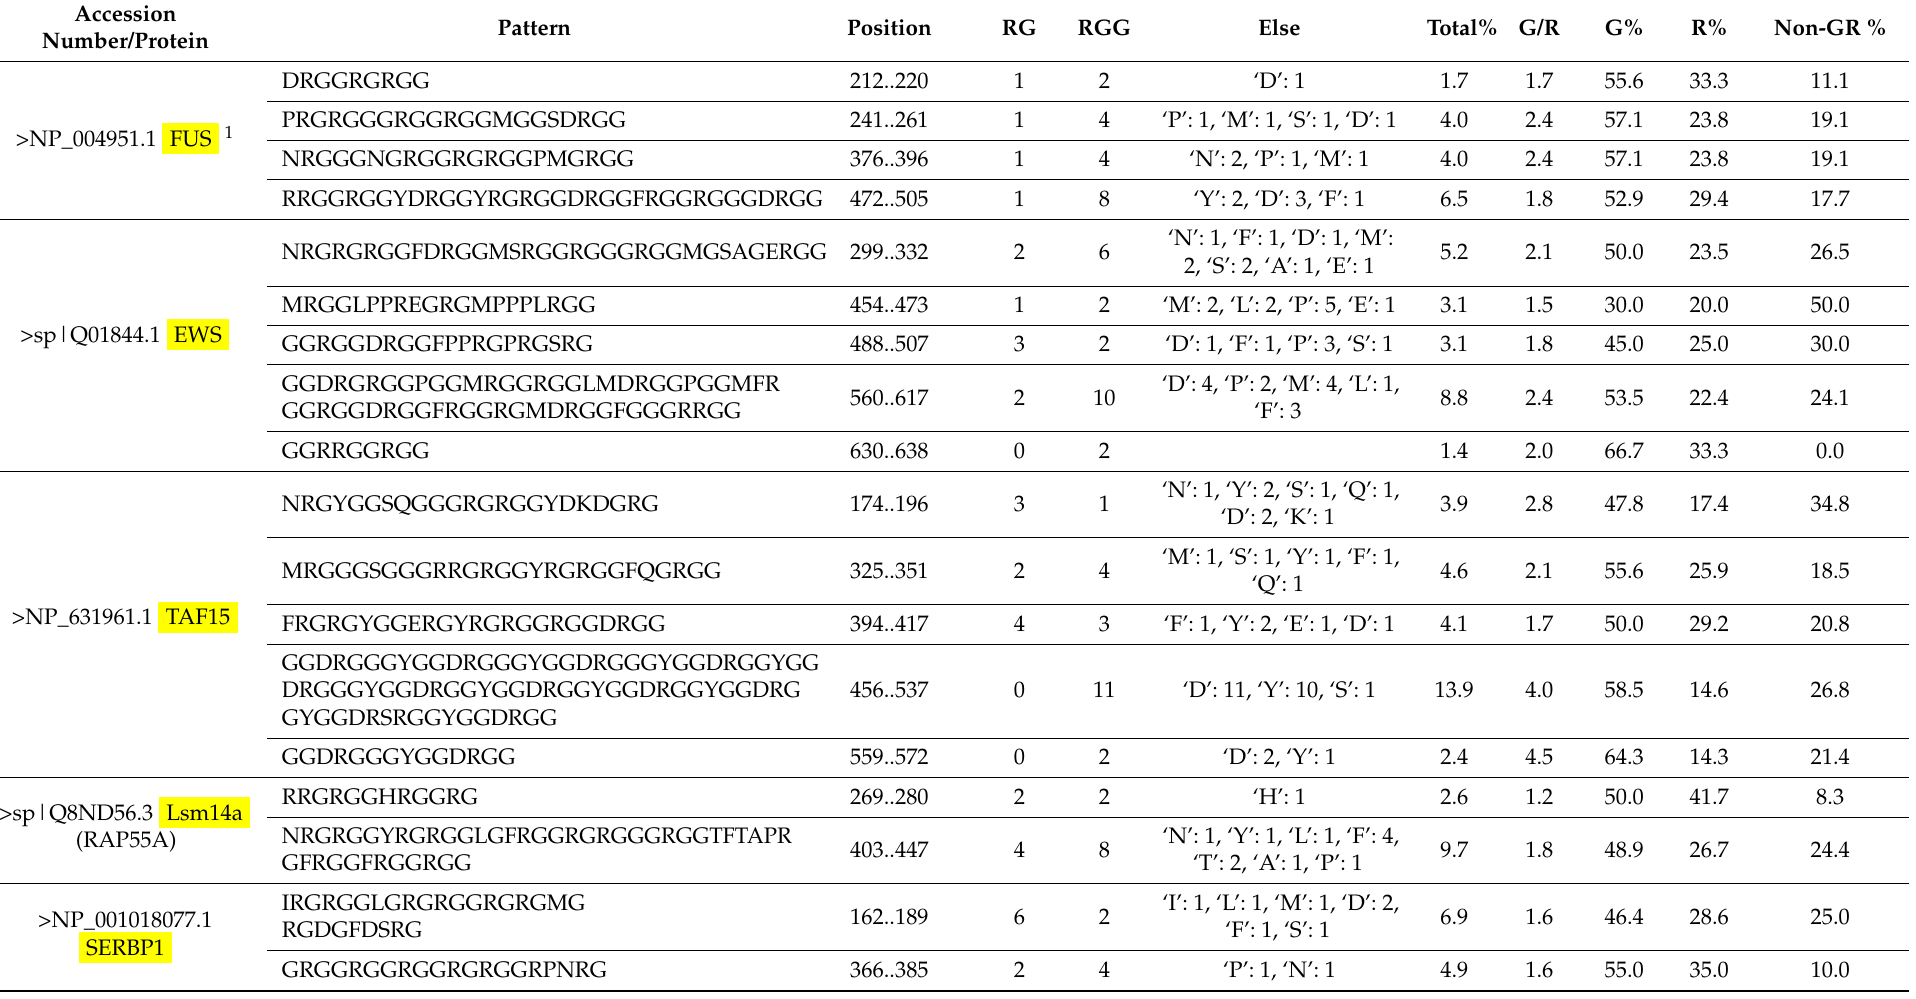
Table 3. Analyses of GAR motifs in selected human RG/RGG-containing proteins by